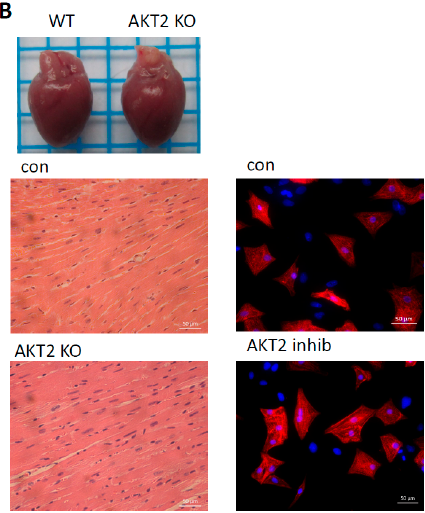
Figure 1. AKT2 inhibition triggers apoptosis-related gene expression without affecting cardiac cell morphology. ( A ) left panel: expression of AKT2, phosphorylated AKT2 (p-AKT2), Bax, Bcl-2, cytochrome C (Cyto C), apoptosis-inducing factor (AIF), endonuclease G (EndoG) and cleaved caspase-3 (cleaved C3) proteins was detected in neonatal cardiomyocytes from 3-day-old rat pups treated with or without AKT2 inhibitor at the concentration of 5 and 10 μ M for 12 and 24 h respectively. Right panel: expression of proteins the same as ( A ) detected in wild type (WT) and AKT2 knockout (KO) mice hearts at 4 months old, 1 and 2 refers to different numbers of heart sample; ( B ) left panel: hearts from WT or AKT2 KO mice at 4 months old and HE staining (×400). Right panel: Immunofluorescence staining of α -actinin ( red ) and hoechst ( blue ) in neonatal rat cardiomyocytes (NRCMs) cultured with or without 10 μ M AKT2 inhibitor (AKT2 inhib) for 12 h (×400). Data are repeated for three independent experiments.